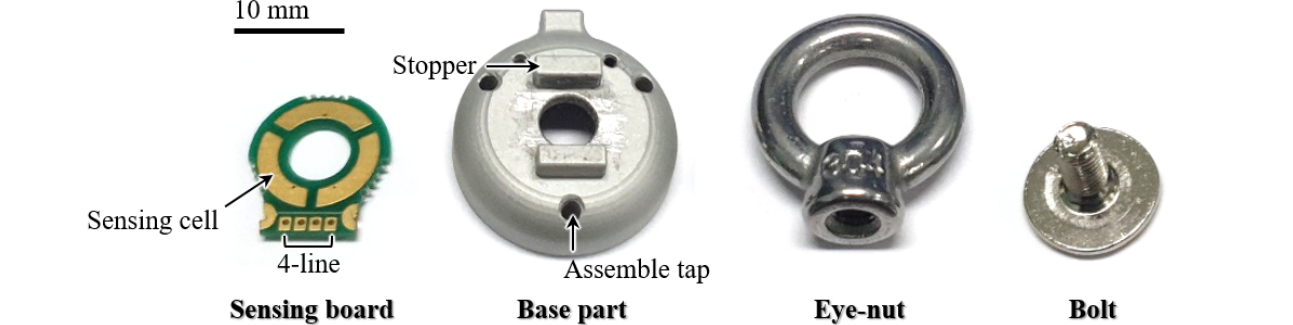
Figure 7. Actual components of the sensor.